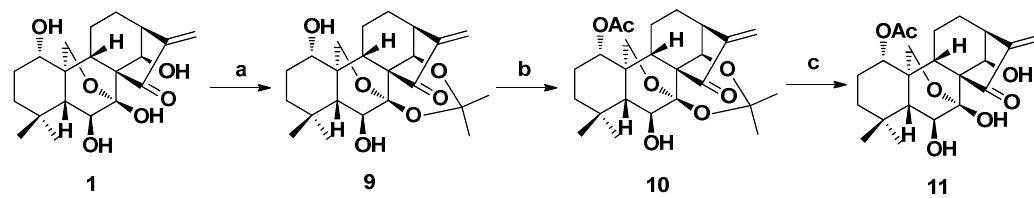
Figure 6. Synthesis routine of lasiokaurin ( 11 ). ( a ) 2,2-Dimethoxypropane, acetone, TsOH, 56 °C; ( b ) Ac 2 O, TEA (triethylamine), DMAP (4-dimethylaminopyridine), rt (room temperature); ( c ) 10% HCl, THF (tetrahydrofuran), rt.